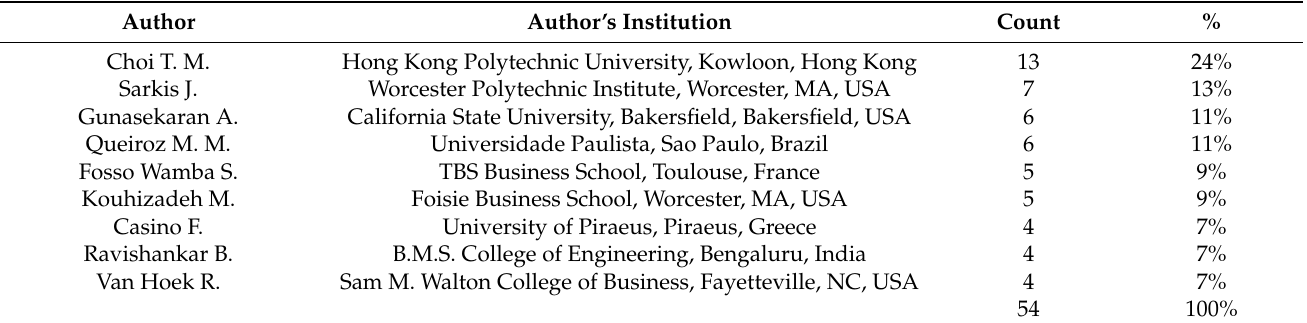
Table 3. Top ten most productive authors according to number of published papers.